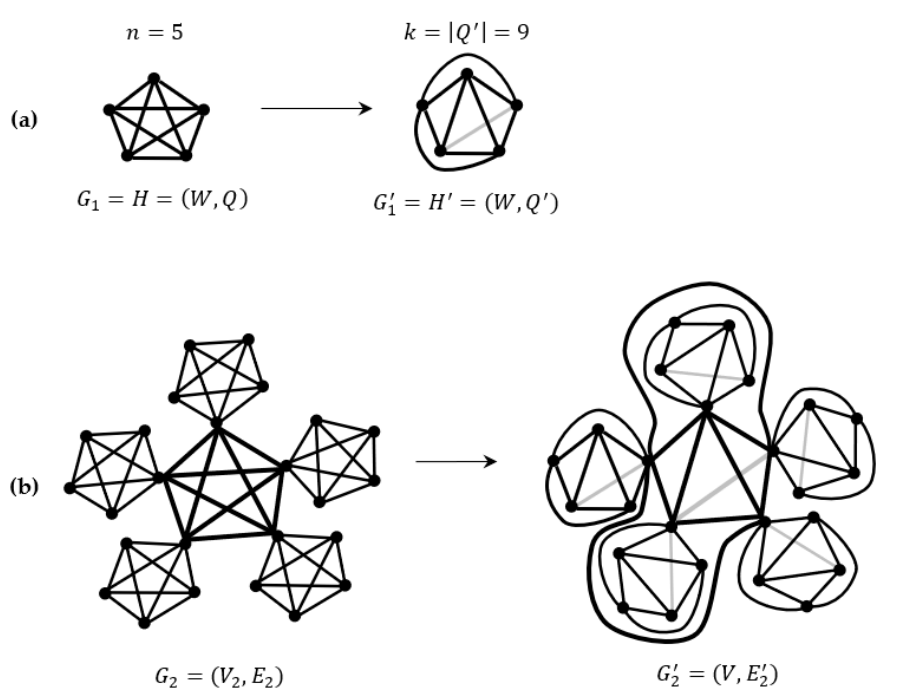
Figure 12. Procedure for isolating a planar subgraph of a prefractal graph when the adjacency of old edges is